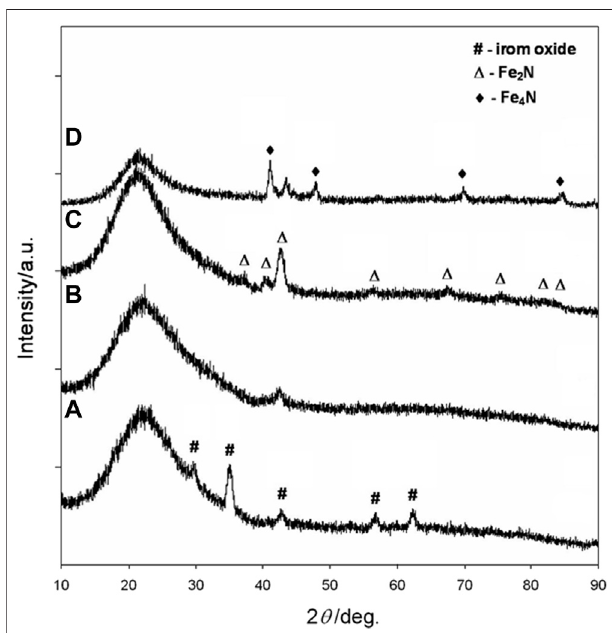
FIGURE 3 | XRD patterns of 10.3 nm iron oxide nanoparticles coated with silica shells and reacted with ammonia gas at (A) 400 ° C (B) 500 ° C (C) 600 ° C, and (D) 700 ° C for 15 h.